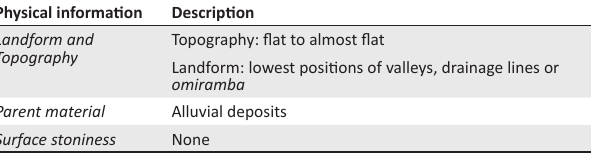
TABLE A1.2a: Differentiating characteristics of the calcaric Fluvisols.